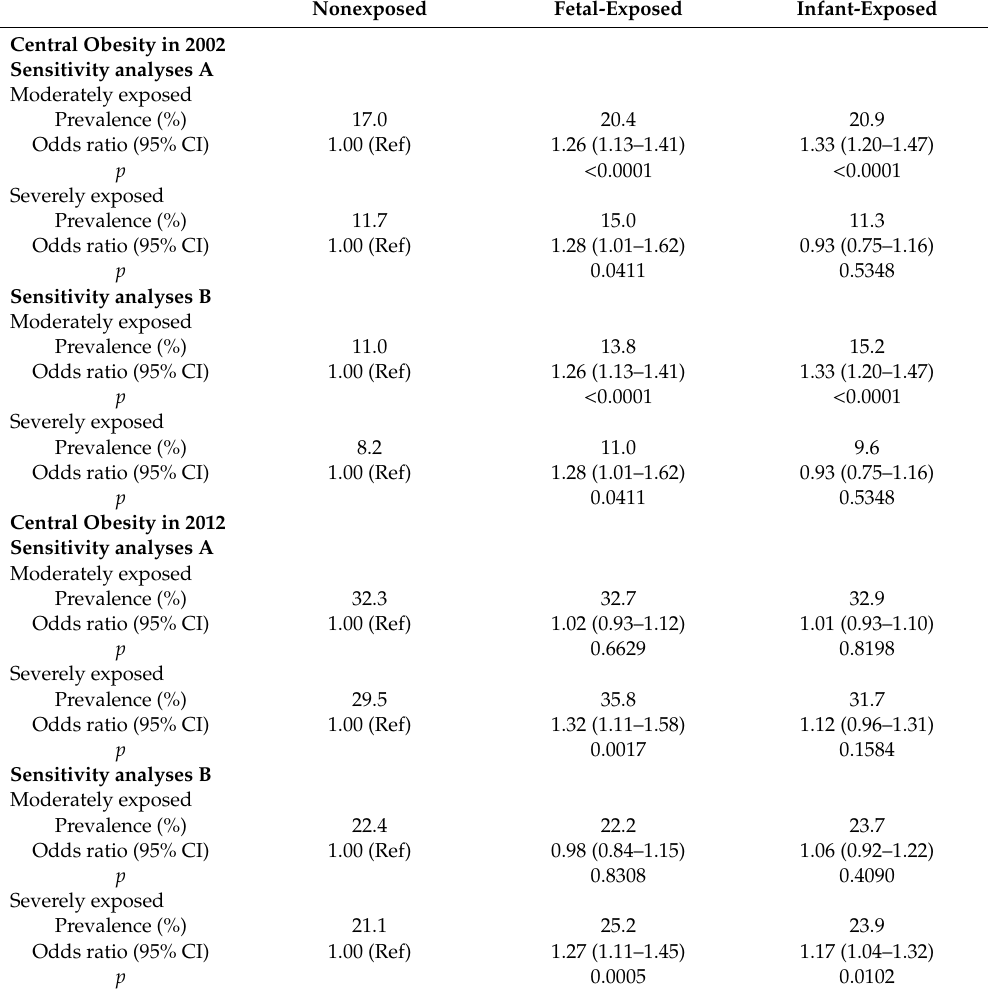
Table 3. Associations of famine exposure with central obesity risk in di ff erent severity of famine areas: sensitivity